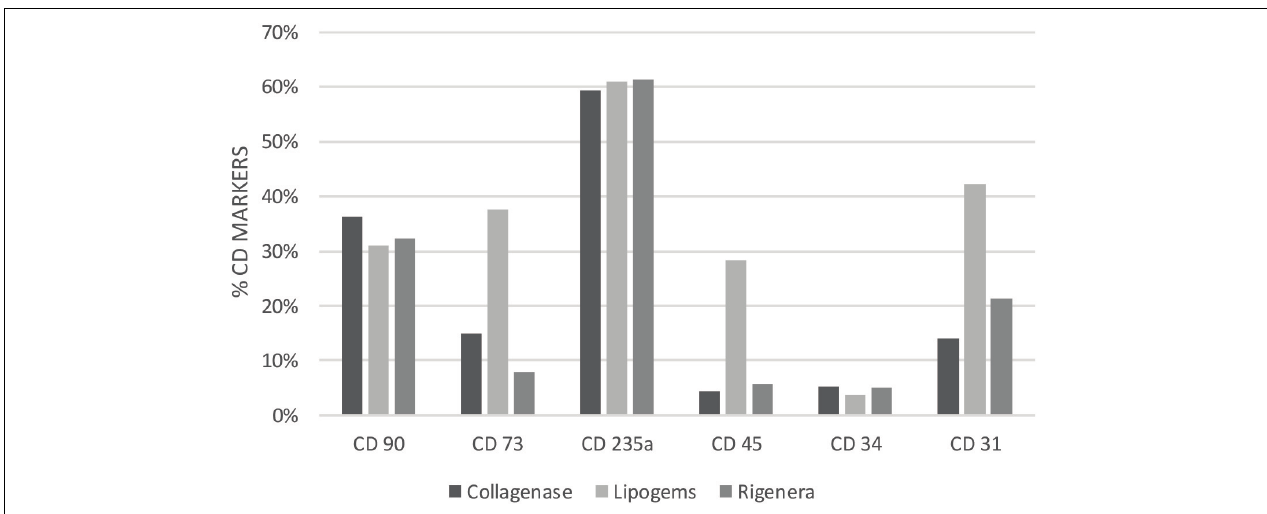
FIGURE 3 | Percentage of staining CD cell (as average of the samples) for each method and technique analyzed. Collagenase: CD90 36% (+), CD73 15% (–), CD235a 59% (+), CD45 4% (–) CD34 5% (–) CD31 14% (–). Lipogems: CD90 31% (+), CD73 38% (+), CD235a 61% (+), CD45 28% (+) CD34 4% (–) CD31 42% (+).